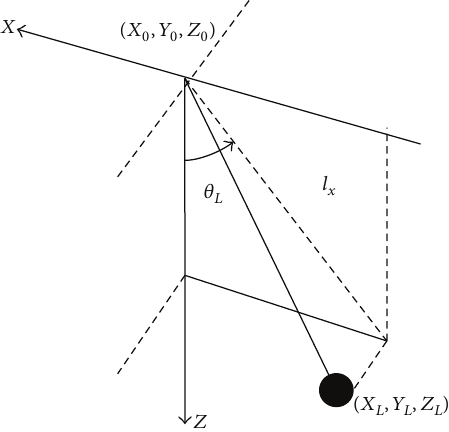
Figure 1: Coordinate system for the longitudinal motion in the 𝑋 - 𝑍